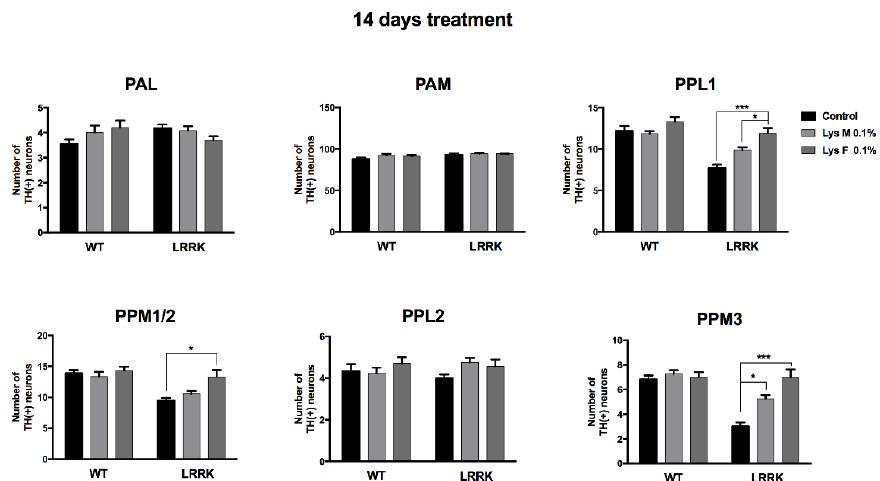
Figure 6. E ff ects of mDLE and fDLE treatments on neuron numbers in DA clusters of WT and LRRK flies. Graphs show no di ff erences in the number of DA neurons in protocerebral anterior medial (PAM) and protocerebral anterior lateral (PAL) of the di ff erent groups. The treatments with mDLE and fDLE at 14 days significantly prevent the loss of DA neurons in the posterior clusters (protocerebral posterior lateral (PPL)1, PPL2, and protocerebral posterior medial (PPM)1 / 2 and PPM3) of LRRK2 WD40 . * = p < 0.05; *** = p < 0.001 in control groups (10 hemispheres for each group, Tukey’s test).